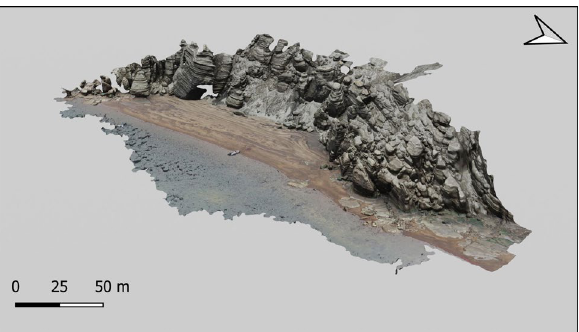
Figure 2. 3D photogrammetry of the Murature formation built with 843 RGB pictures taken from the RGB Hasselblad camera quadcopter DJI Mavic 2 Zoom at 40-m altitude, achieving 1.4 cm/pixel